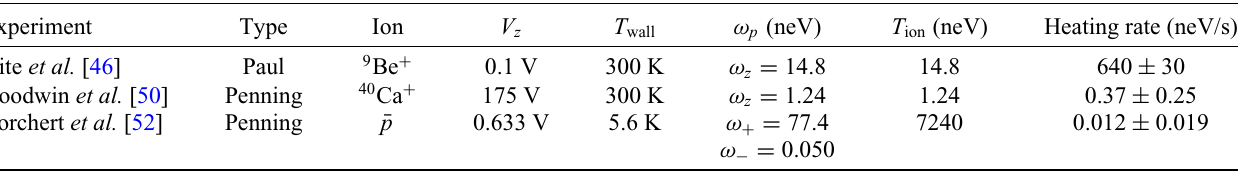
TABLE I. A list of ion traps and the relevant experimental parameters used for setting limits in this paper. The ion used, V z , the potential barrier in the axial direction, T wall , the temperature of the walls of the trap, and ω p , the fundamental frequency of the trap in the relevant direction, are listed. Also listed are T ion , the temperature of the ion in the trap, and the measured heating rate. Experiment